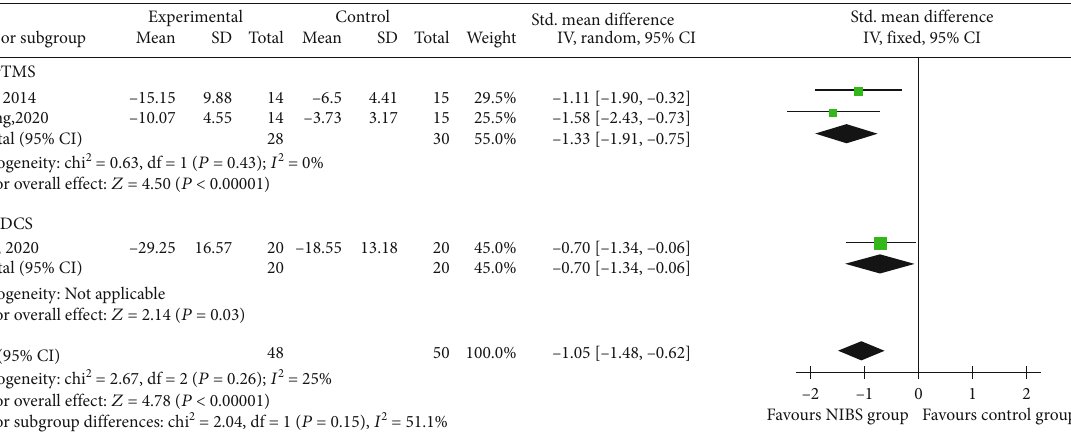
CIStd. mean difference IV, random, 95% CI